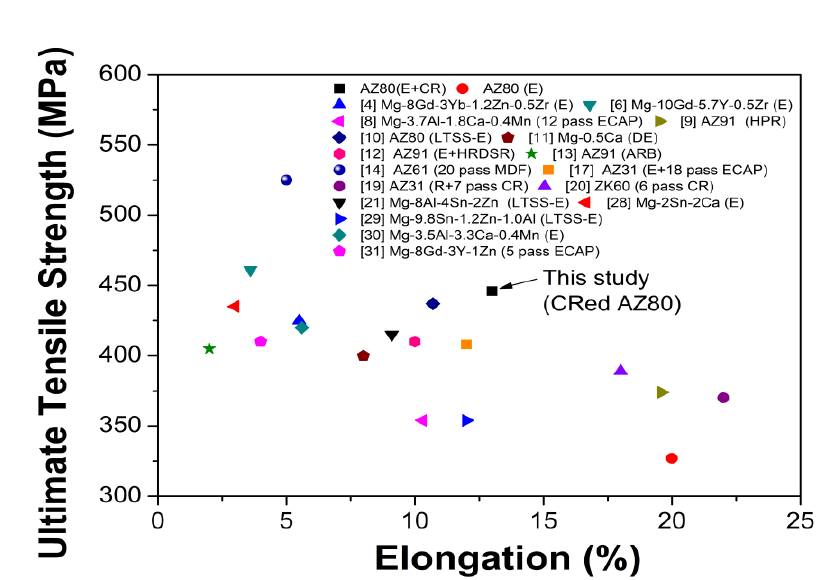
Figure 9. Comparison of UTS vs. EL of CRed AZ80 with previously reported wrought Mg Alloys [4,6,8–14,17,19,21,28–31] (E: Extrusion; CR: Calibre rolling; ECAP: Equal channel angular pressing; HPR: Hard plate rolling; LTSS-E: low temperature slow speed extrusion; DE: Double extrusion; HRDSR: High-ratio differential speed rolling; ARB: Accumulative roll bonding; R: Rolling; MDF: Multi-directional forging).